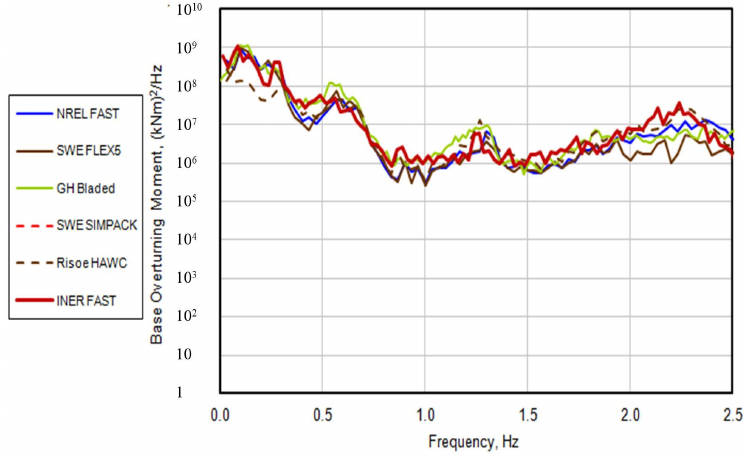
Figure 5. Power Spectra of Base Overturning Moment under Load Case 5.3 of OC3 Phase I.